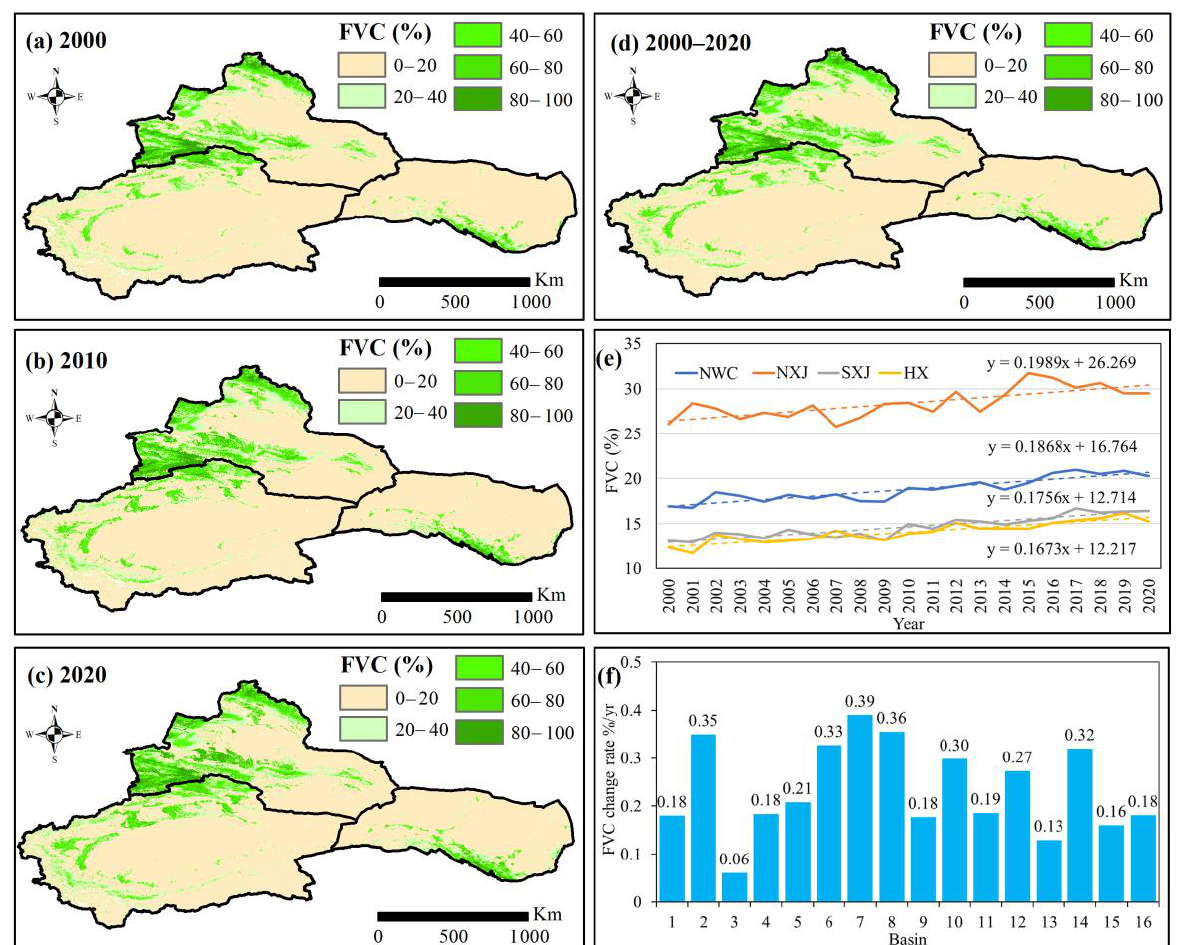
Figure 8. Spatial distribution and variations of FVC from 2000 to 2020. Spatial distribution of FVC during ( a ) 2000, ( b ) 2010, and ( c ) 2020; ( d ) spatial variations of annual average FVC in NWC; ( e ) temporal variations of NDVI in NWC, NXJ, SXJ and HX; ( f ) change rates in NDVI in different basins in NWC: (1) Irtysh River basin, (2) Emin River basin, (3) Ili River basin, (4) Kaidu River basin, (5) Kongqi River basin, (6) Dina River basin, (7) Weigan-Kuche River basin, (8) Aksu River basin, (9) Keriya River basin, (10) Kashgar River basin, (11) Hotan River basin, (12) Yarkand River